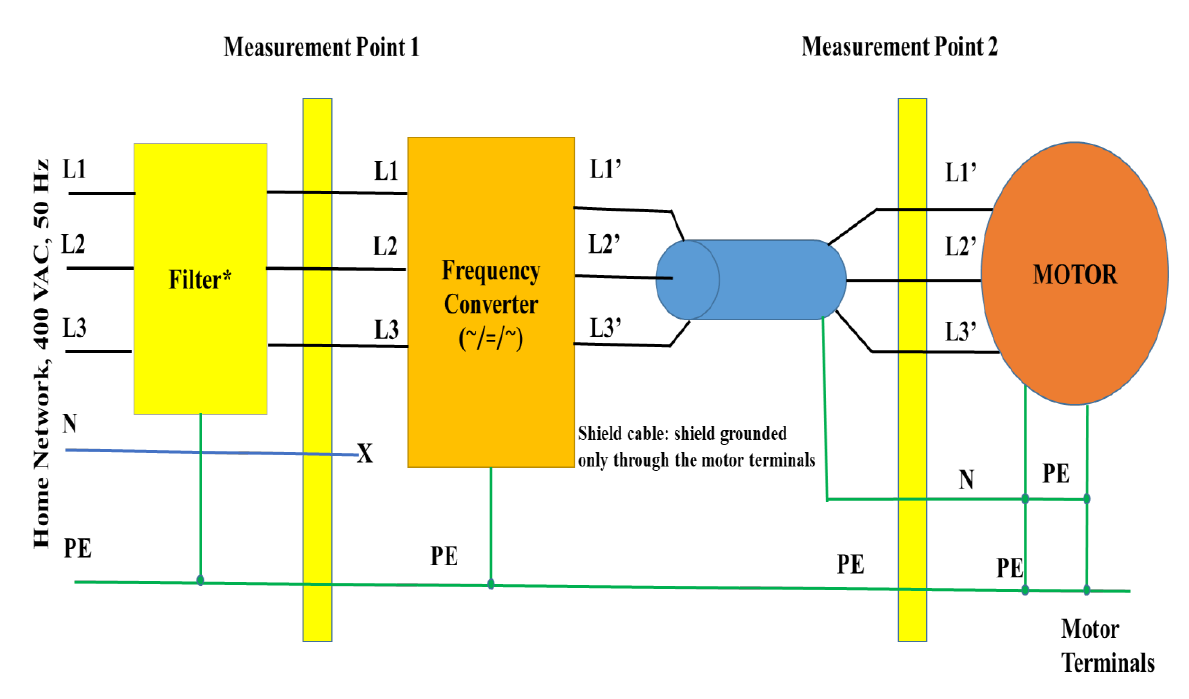
Figure 1. Drive supply circuit diagram (high current component). Table 1. Technical specification of the frequency converter [34].